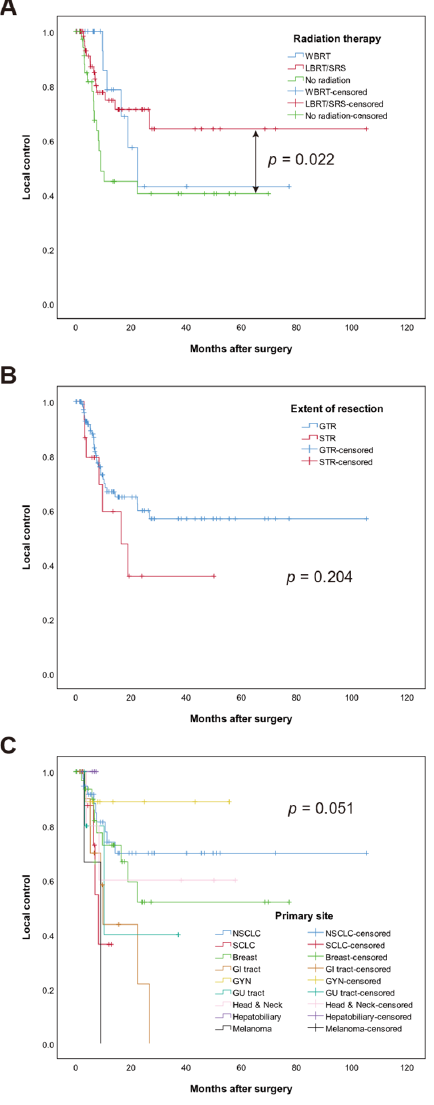
Figure 2. Kaplan–Meier curves of local control (LC) in months among 124 patients. The median LC values in each group were as follows: ( A ) radiation therapy, mean local recurrence-free survival time was 71.6 vs. 40.4 vs. 33.7, (LBRT/SRS vs. WBRT vs. No radiation, respectively p = 0.022) ( B ) extent of resection, mean local recurrence-free survival time was 64.4 vs. 24.6 (GTR vs. STR), respectively ( p = 0.204), ( C ) primary site of brain metastases (BM) ( p =